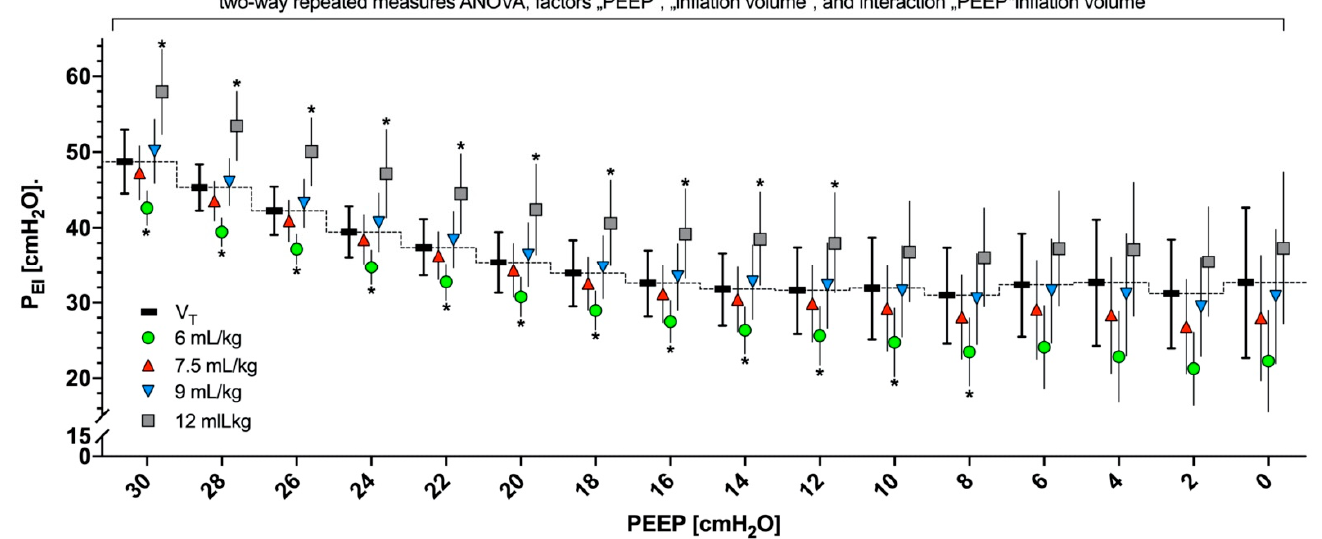
Figure 6. End-inspiratory pressure (PEI) resulting from slow inflation with tidal volumes (VTs) of 12 (gray), 9 (blue), 7.5 (red), and 6 (green) mL/kg and regular VTs of 8 mL/kg of body weight (BW; black, connected by the dashed line) during a decremental PEEP trial from 30 to 0 cm H 2 O. Repeated-measures analysis of variance (ANOVA) included the factors PEEP, inflation volume, and the interaction of these factors. * Asterisks indicate the significant results of consecutive post hoc tests ( p < 0.05, multiple comparison) for the differences between PEI resulting from different slow inflation volumes and PEI resulting from regular low VTs.